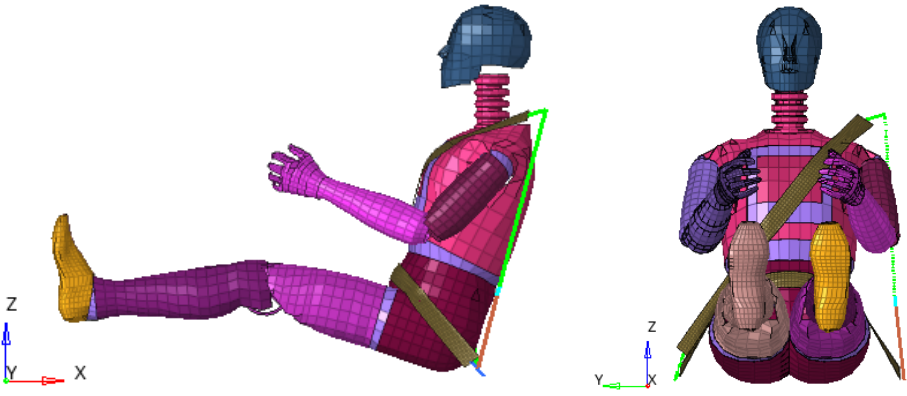
Figure 3. The dummy and the seat belt system (side and front view—Hybrid III 50th Male FE).